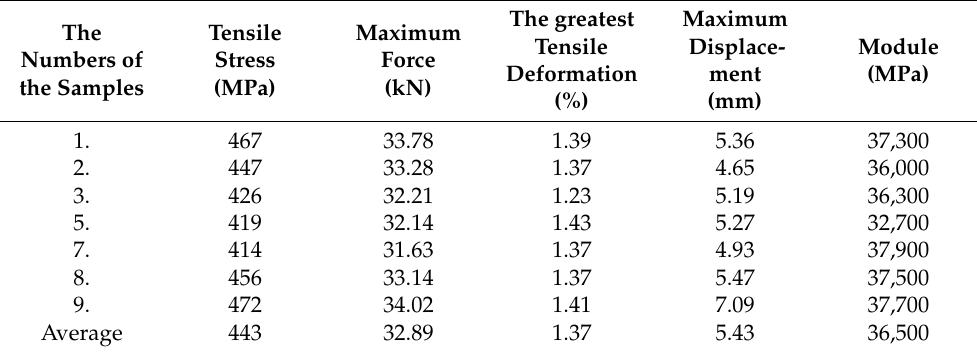
Table 7. Analysis of the obtained test results for the composite laminate reinforced with the symmet- rical Interglas 02037 fabric, 0/90 ◦